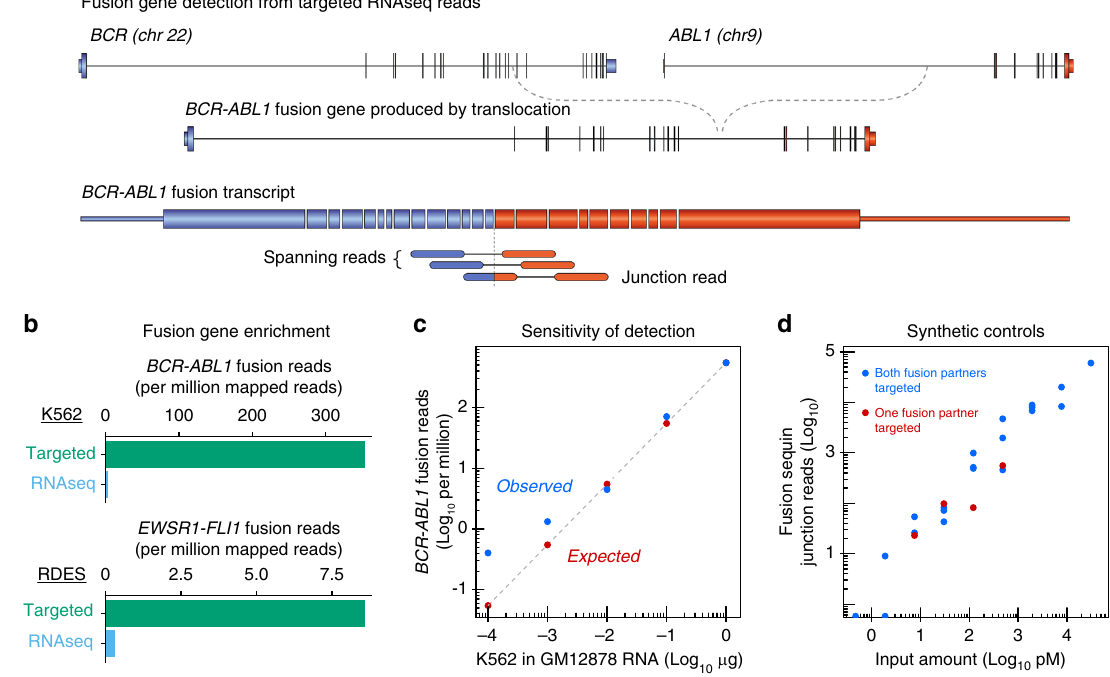
Fig. 2 Validation of targeted RNAseq for fusion gene detection. a Diagram of BCR-ABL1 fusion gene and transcript, depicting spanning and junction reads used to identify fusion genes. b Bar charts comparing abundance of fusion reads from targeted and canonical RNASeq libraries in K562 (top) and RDES (bottom) cell lines. c Scatterplot of observed (blue dots) and expected (red dots) BCR-ABL1 read counts in K562 dilution series. d Scatterplot of fusion sequin junction reads versus input